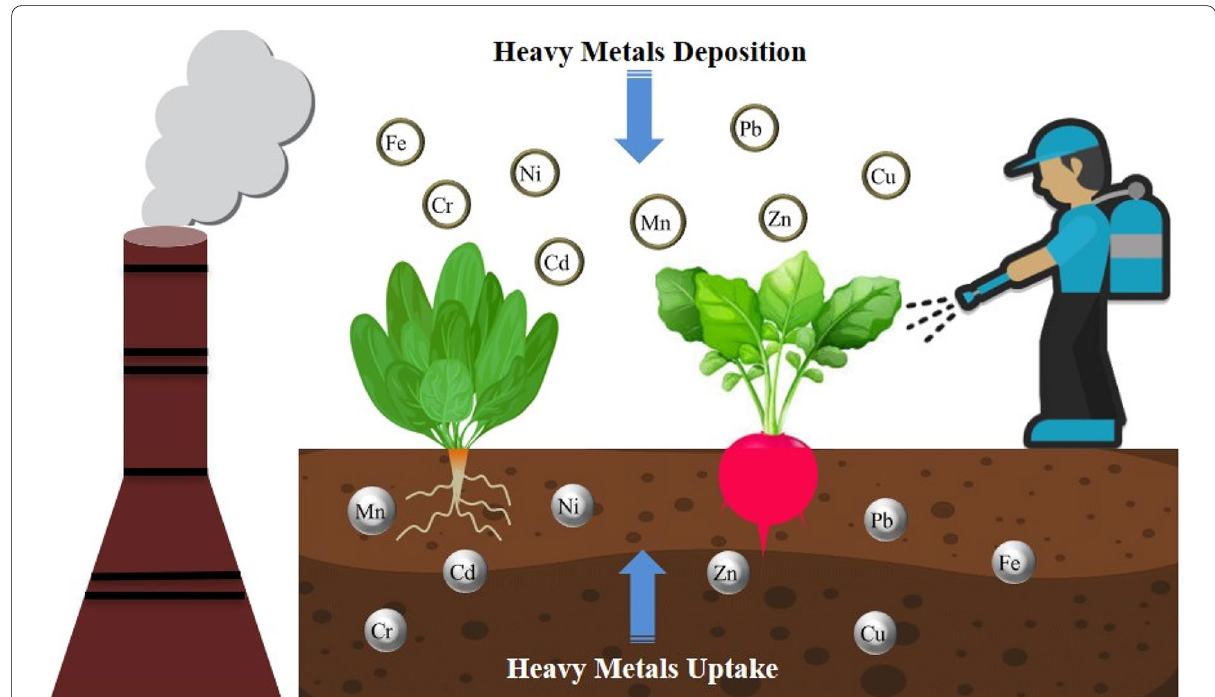
Fig. 1 Conceptual schematic of the uptake and deposition of heavy metals in root and leafy